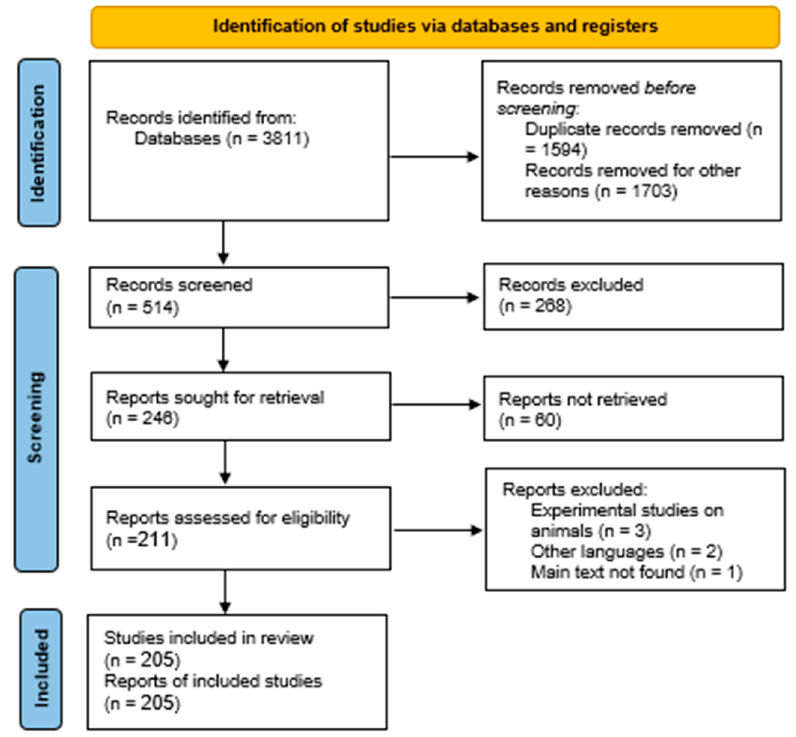
Figure 2. Systematic review flowchart according to PRISMA 2020.